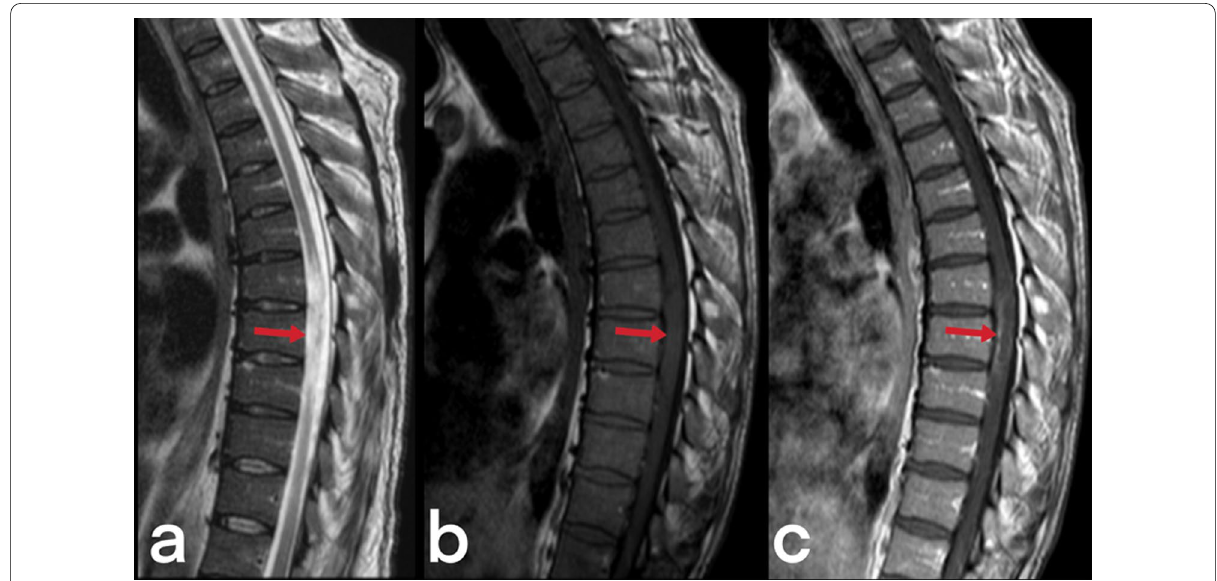
Fig. 6 MR images of a 56-year-old male with the diagnosis of tuberculous myelitis. Sagittal T2 weighted image ( a ) shows a heterogeneous increased signal on the spinal cord (arrow). Pre-contrast ( b ) and post-contrast ( c ) T1 weighted images reveal linear contrast enhancement of the same region (arrows)